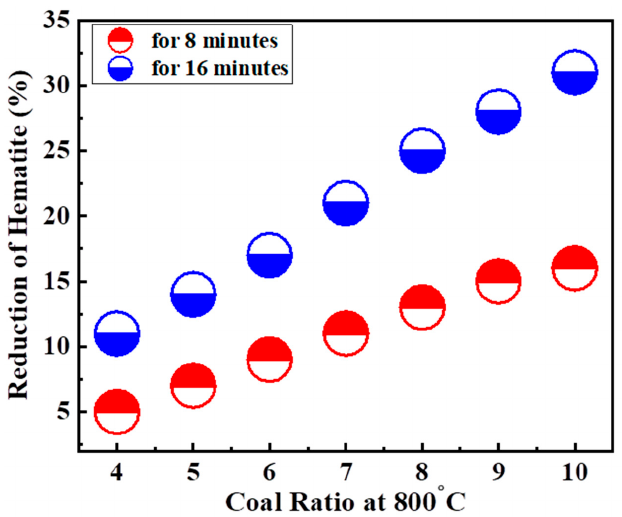
Figure 4. Effect of coal ratio at 800 °C for the reduction of hematite.